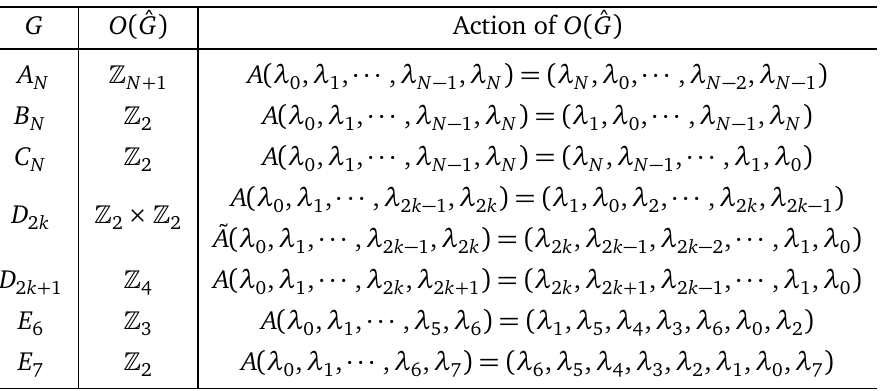
Table 4: Outer automorphism of the affine Lie algebras are listed in this